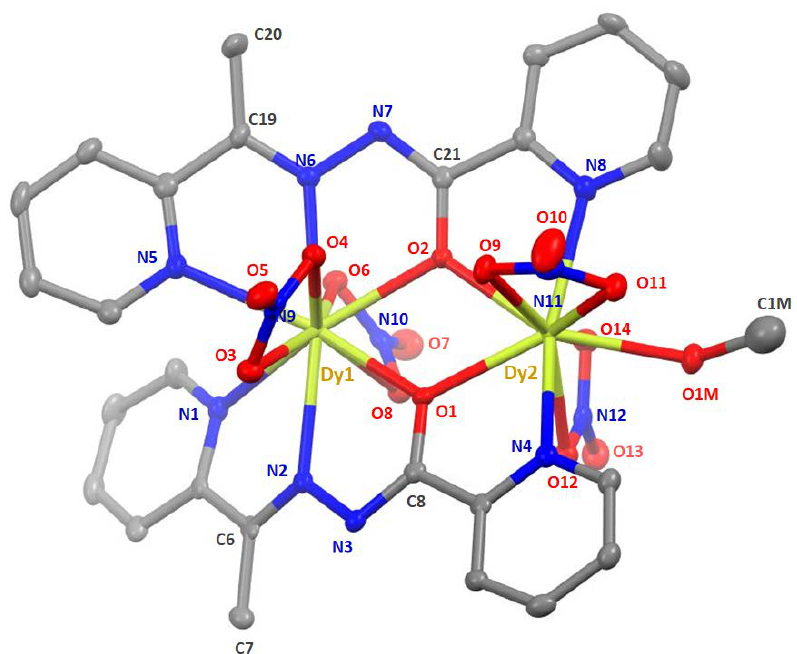
Figure 4. Molecular structure of [Dy 2 (NO 3 ) 4 (L) 2 (MeOH)] as found in 3 · 2.5MeOH at 120 K. Thermal ellipsoids are depicted at 50% probability level. Hydrogen atoms are omitted for clarity. Note that only the major complex is depicted here, i.e., with coordinated MeOH instead of H 2 O, C1M having an occupancy of ca. 0.7.